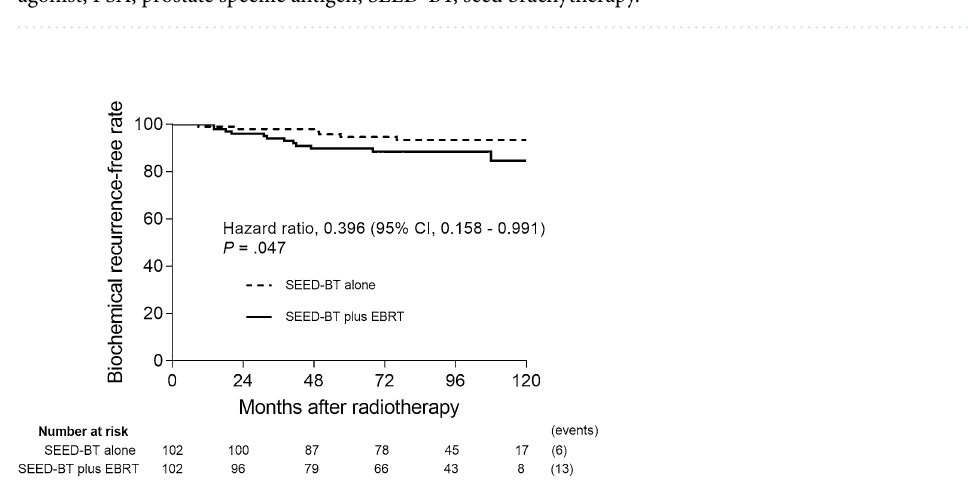
Table 1. Patients characteristics after propensity-score matching. Prostate D90 indicates minimal dose received by 90% of prostate gland at 1 month on SEED-BT. Prostate V100 and V150 indicates percentage of prostate gland volume receiving 100% and 150% of the prescribed dose, respectively, at 1 month on SEED-BT. BED, biochemical effective dose; EBRT, external beam radiotherapy; GnRHa, gonadotropin-releasing hormone agonist; PSA, prostate specific antigen; SEED-BT, seed brachytherapy.